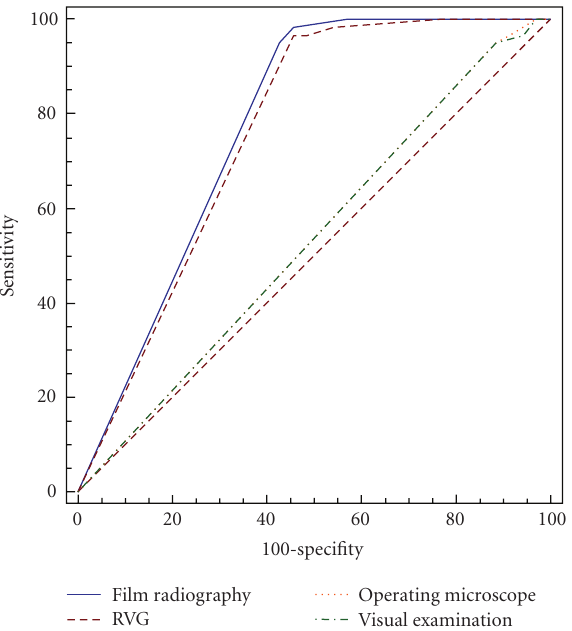
Figure 2: ROC curve for 3rd